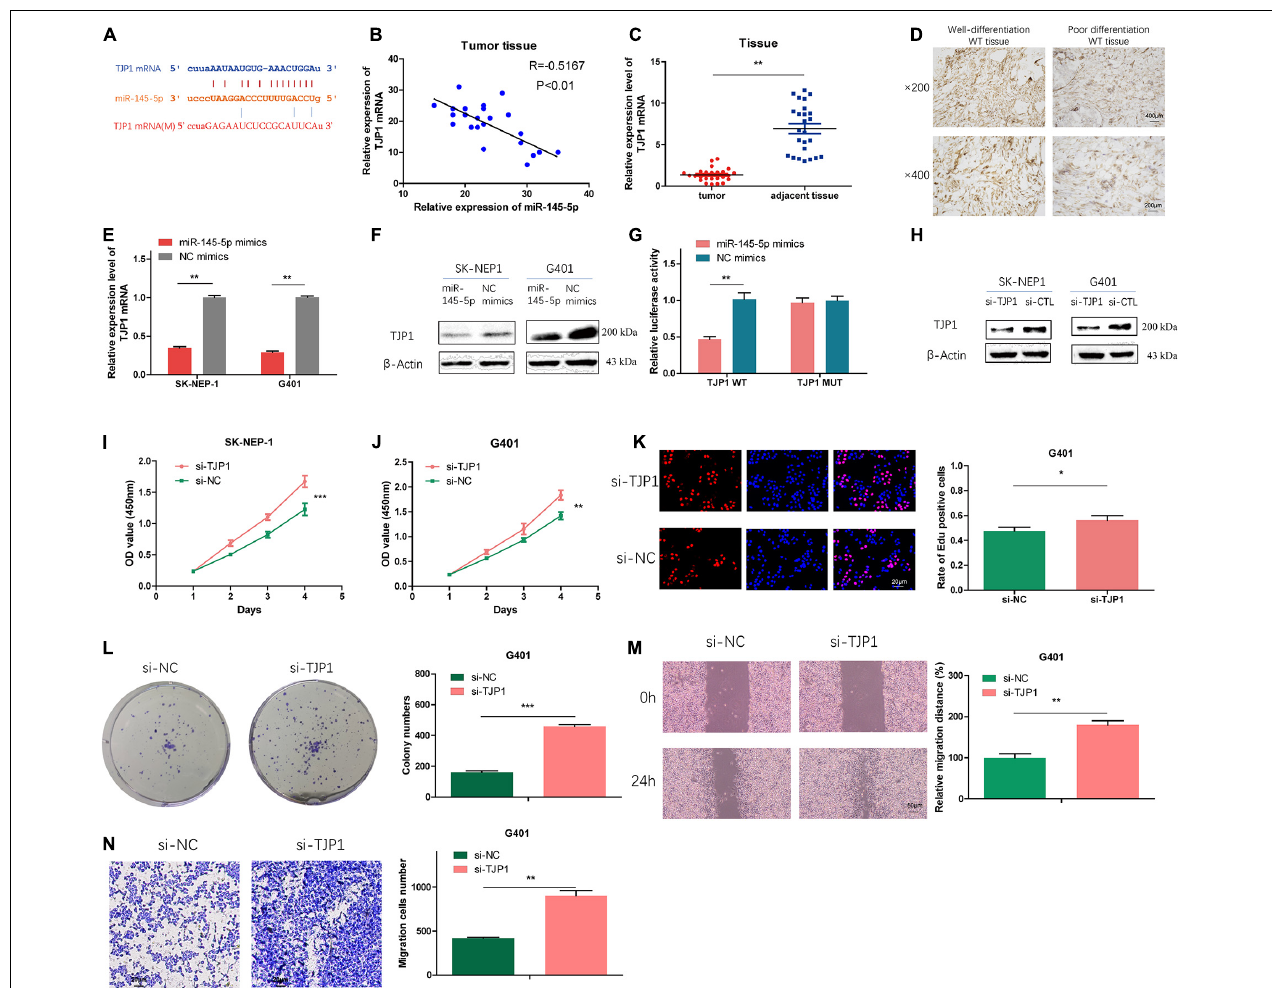
FIGURE 5 | TJP1 is a direct-target gene of miR-145-5p, which could reduce proliferation, migration, and invasion in WT cells. (A) Possible binding sites between TJP1 mRNA and miR-145-5p. (B) The relative expression of TJP1 mRNA had a negative correlation with miR-145-5p in the WT tissue by RT-qPCR. (C) The relative expression of TJP1 mRNA in tumor and adjacent non-tumor tissue by RT-qPCR. (D) TJP1 expression in WT tissue by immunochemistry. (E) The expression of TJP1 mRNA determined by RT-qPCR in SK-NEP-1 and G401 cells overexpressing miR-145-5p. (F) TJP1 was the direct target of miR-145-5p through dual-luciferase reporter assays. (G) The expression of TJP1 protein by Western blot in SK-NEP-1 and G401 cells overexpressing miR-145-5p. (H) The expression of TJP1 protein by Western blot in SK-NEP-1 and G401 cells transfected by si-TJP1 or si-NC. (I,J) The proliferation of SK-NEP-1 and G401 transfected by si-TJP1 or si-NC cells by the CCK-8 method. (K,L) The proliferation of G401 cells transfected by si-TJP1 or si-NC by EdU and colony formation assays. (M,N) The migration and invasion of G401 cells transfected by si-TJP1 or si-NC by wound healing assays and transwell assays. Data represent the mean ± SD from three independent experiments. Student’s t -test with two biologically dependent or independent replicates was used to determine statistical significance; *** P < 0.001, ** P < 0.01, * P <